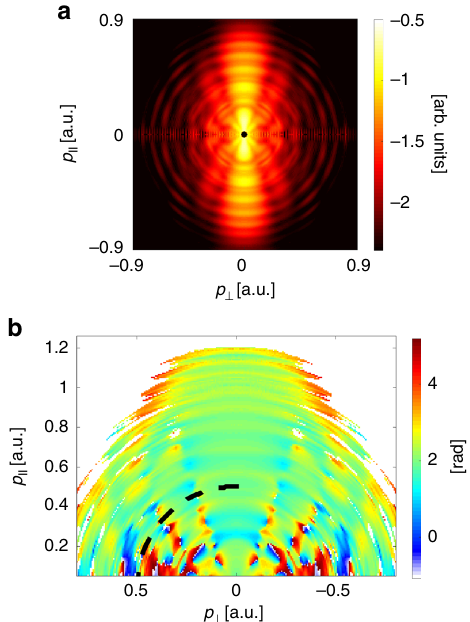
Fig. 2 Two-color photoelectron holography. a Reconstructed photoelectron momentum distribution in log scale measured from argon, using the fundamental laser fi eld only. The interference between the direct and scattered electron trajectories produces a spider-like interference pattern 12 . b Momentum-resolved two-color oscillation phase, ϕ opt ( p || , p ⊥ ), extracted from the two-color scan. The black dashed curve traces electrons with a constant absolute value of the momentum ( p = 0.5 a.u.) and hence traces electrons with equal kinetic energy. The evolution of the two-color phase along this equal energy curve is used to extract the difference between the ionization times of the direct (reference) and scattered (signal) electron trajectories (see